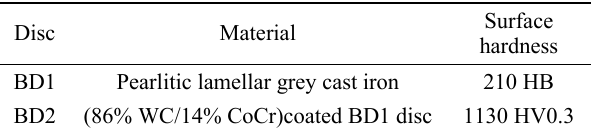
Table 2 Main characteristics of BD1 and BD2 discs analyzed in the present investigation.